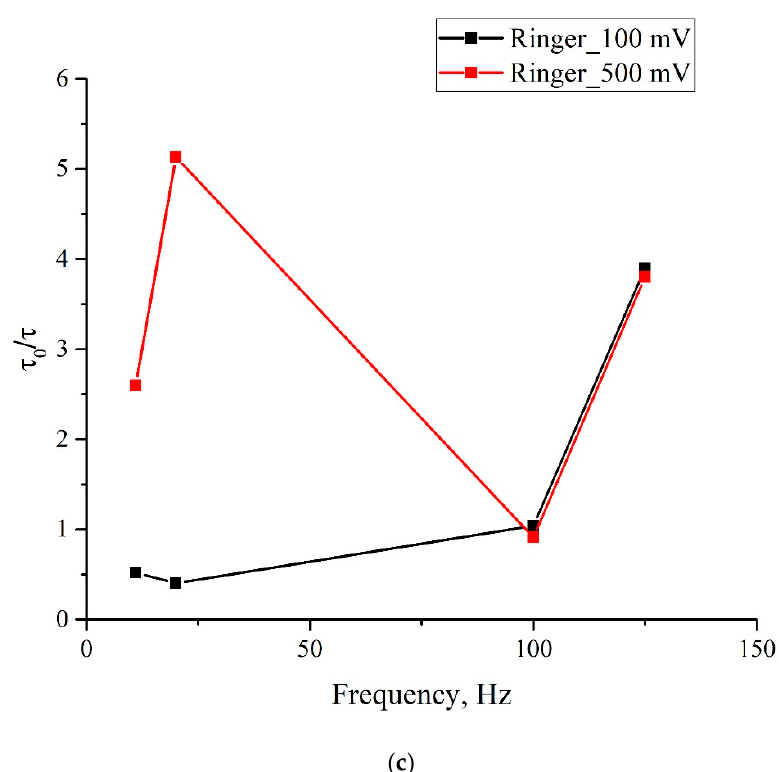
Figure 8. Dependence of τ / τ 0 on the pulse repetition rate for pulse amplitudes of 100 mV (black curve) and 500 mV (red curve); ( a )—deionized water; ( b )—NaCl solution; ( c )—Ringer’ so- lution.